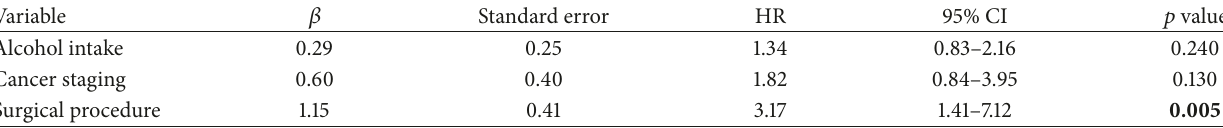
Table 3: Cox regression analysis between three variables studied and